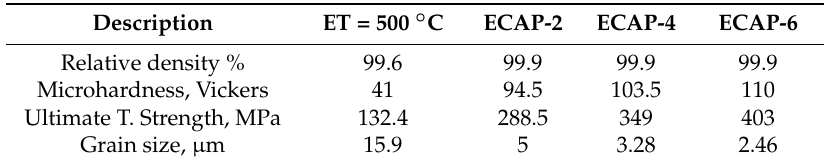
Table 4. Effect of ECAP process on solid-state recycled aluminum Alloy 6061 chips after extrusion (500 ◦ C).